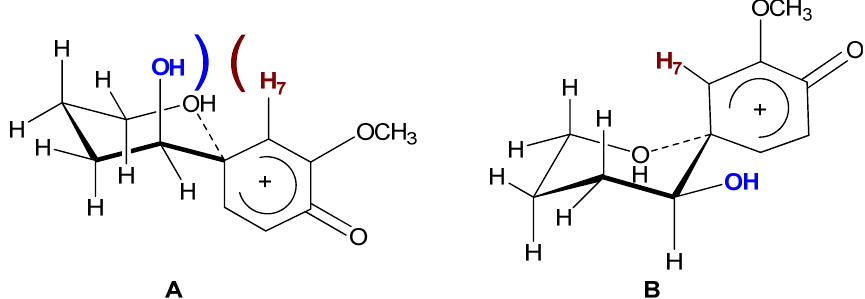
Figure 3. Chair-like conformations of the potential